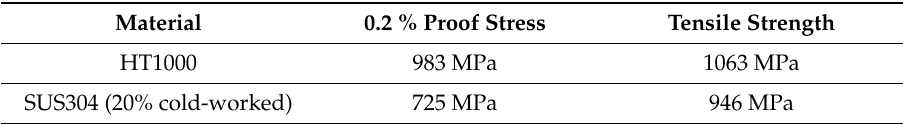
Table 3. Mechanical properties of HT1000 and